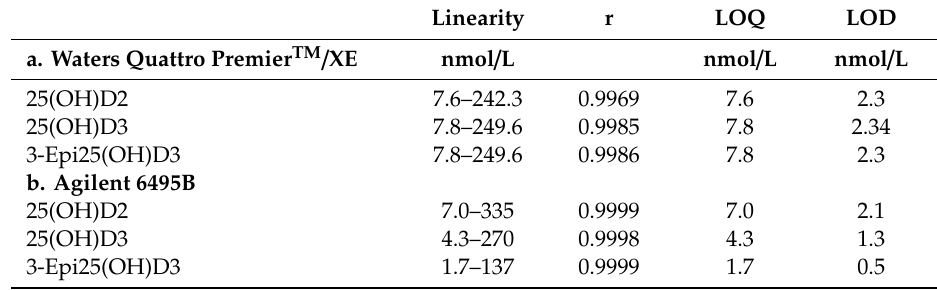
Table 1. Linearity, limit of quantification, and limit of detection of vitamin D metabolites measured